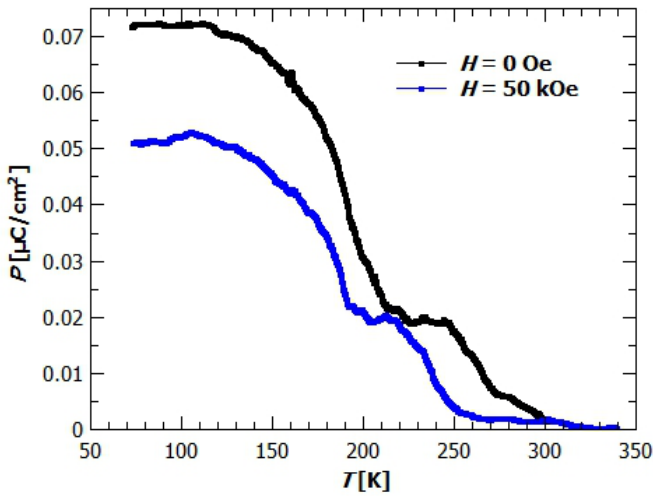
Figure 8. Polarisation of GuaCuF. Measured in c direction while cooling. The black circles represent measurement in zero magnetic field and blue rectangles in 50 kOe magnetic